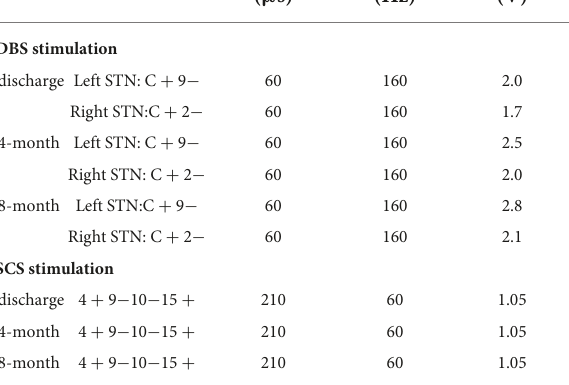
TABLE 2 The stimulation parameters of DBS and SCS at discharge and 4- and 8-month